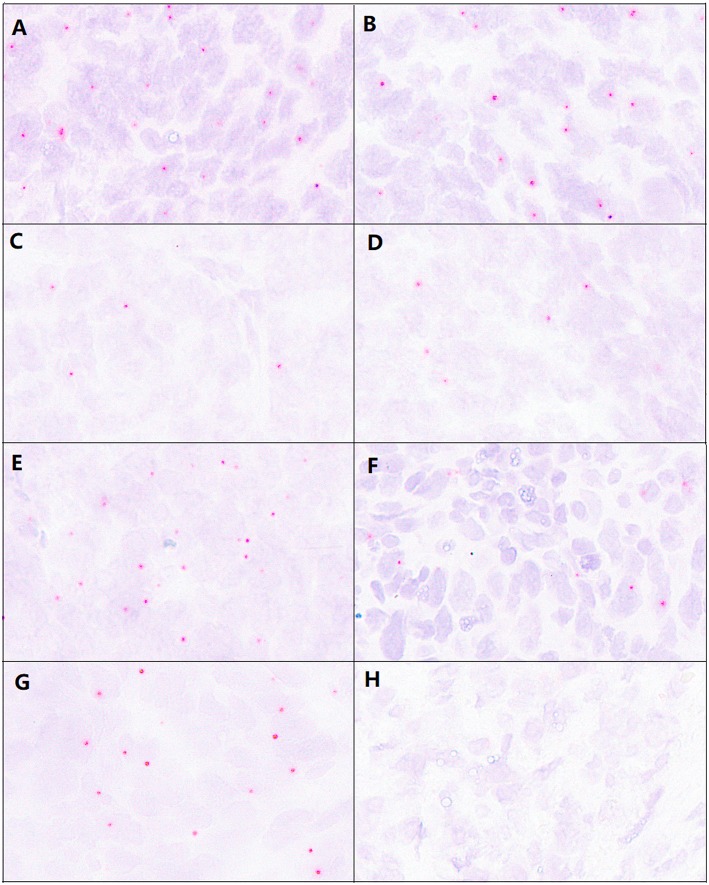
Comparison of detection results from mixed and single probes and paraffin section signal images before and after 5 months. (A) The signal of the P286R probe in P286R mutated high-grade EC. (B) The signal of mixed probes (P286R and V411L probe) in P286R mutated high-grade EC. (C) The signal of the V411L probe in V411L mutated high-grade EC. (D) The signal of mixed probes (P286R and V411L probe) in V411L mutated high-grade EC. (E,F) The detection using the P286R probe in P286R high-grade EC paraffin section before (E) and after (F) 5 months, the hybridization signal counts were significantly reduced 5 months after in paraffin sections. (G,H) The detection using the V411L probe in V411L high-grade EC paraffin section before (E) and after (F) 5 months, the hybridization signal counts were significantly reduced 5 months after in paraffin sections.